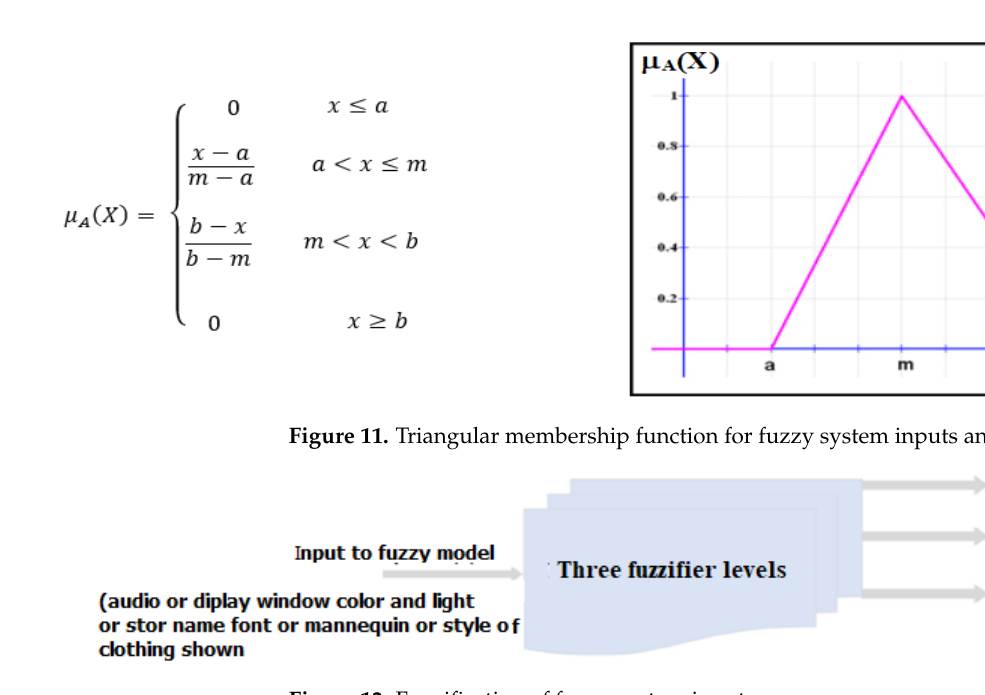
Figure 12. Fuzzification of fuzzy system inputs.